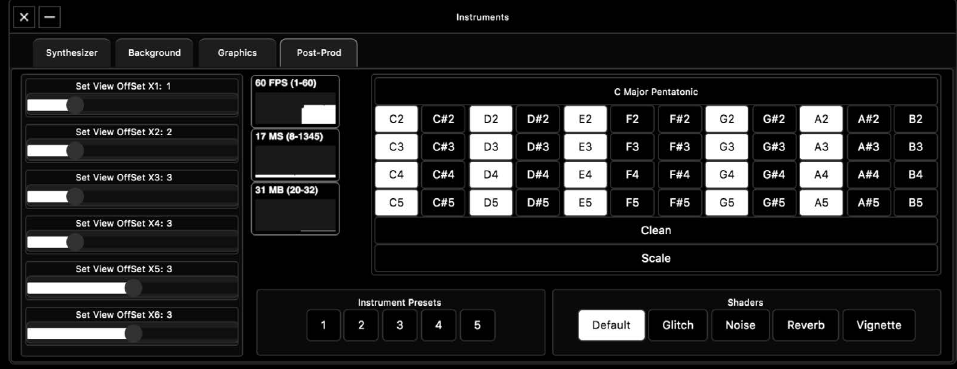
Figure 8: GUI Elements of Akson: 7) Instruments Dialog – Post-Prod tab.